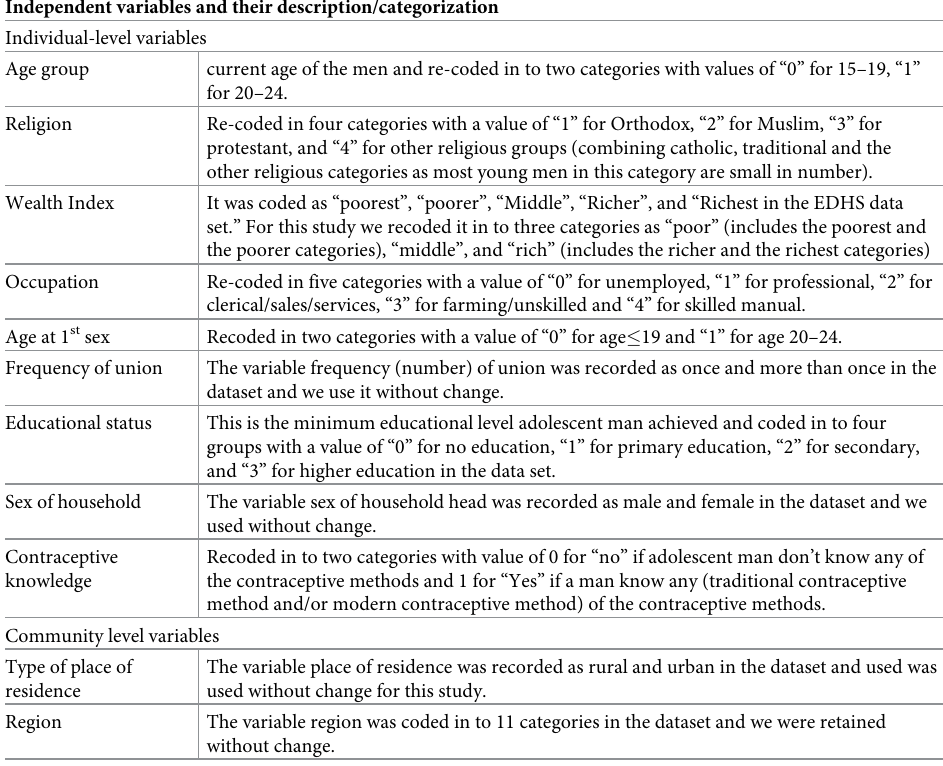
Table 1. Description and measurement of independent